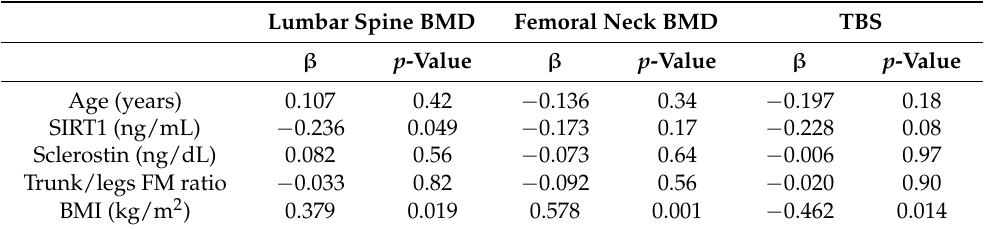
Table 3. Multiple regression analysis for best predictors of lumbar spine BMD, femoral neck BMD and TBS.